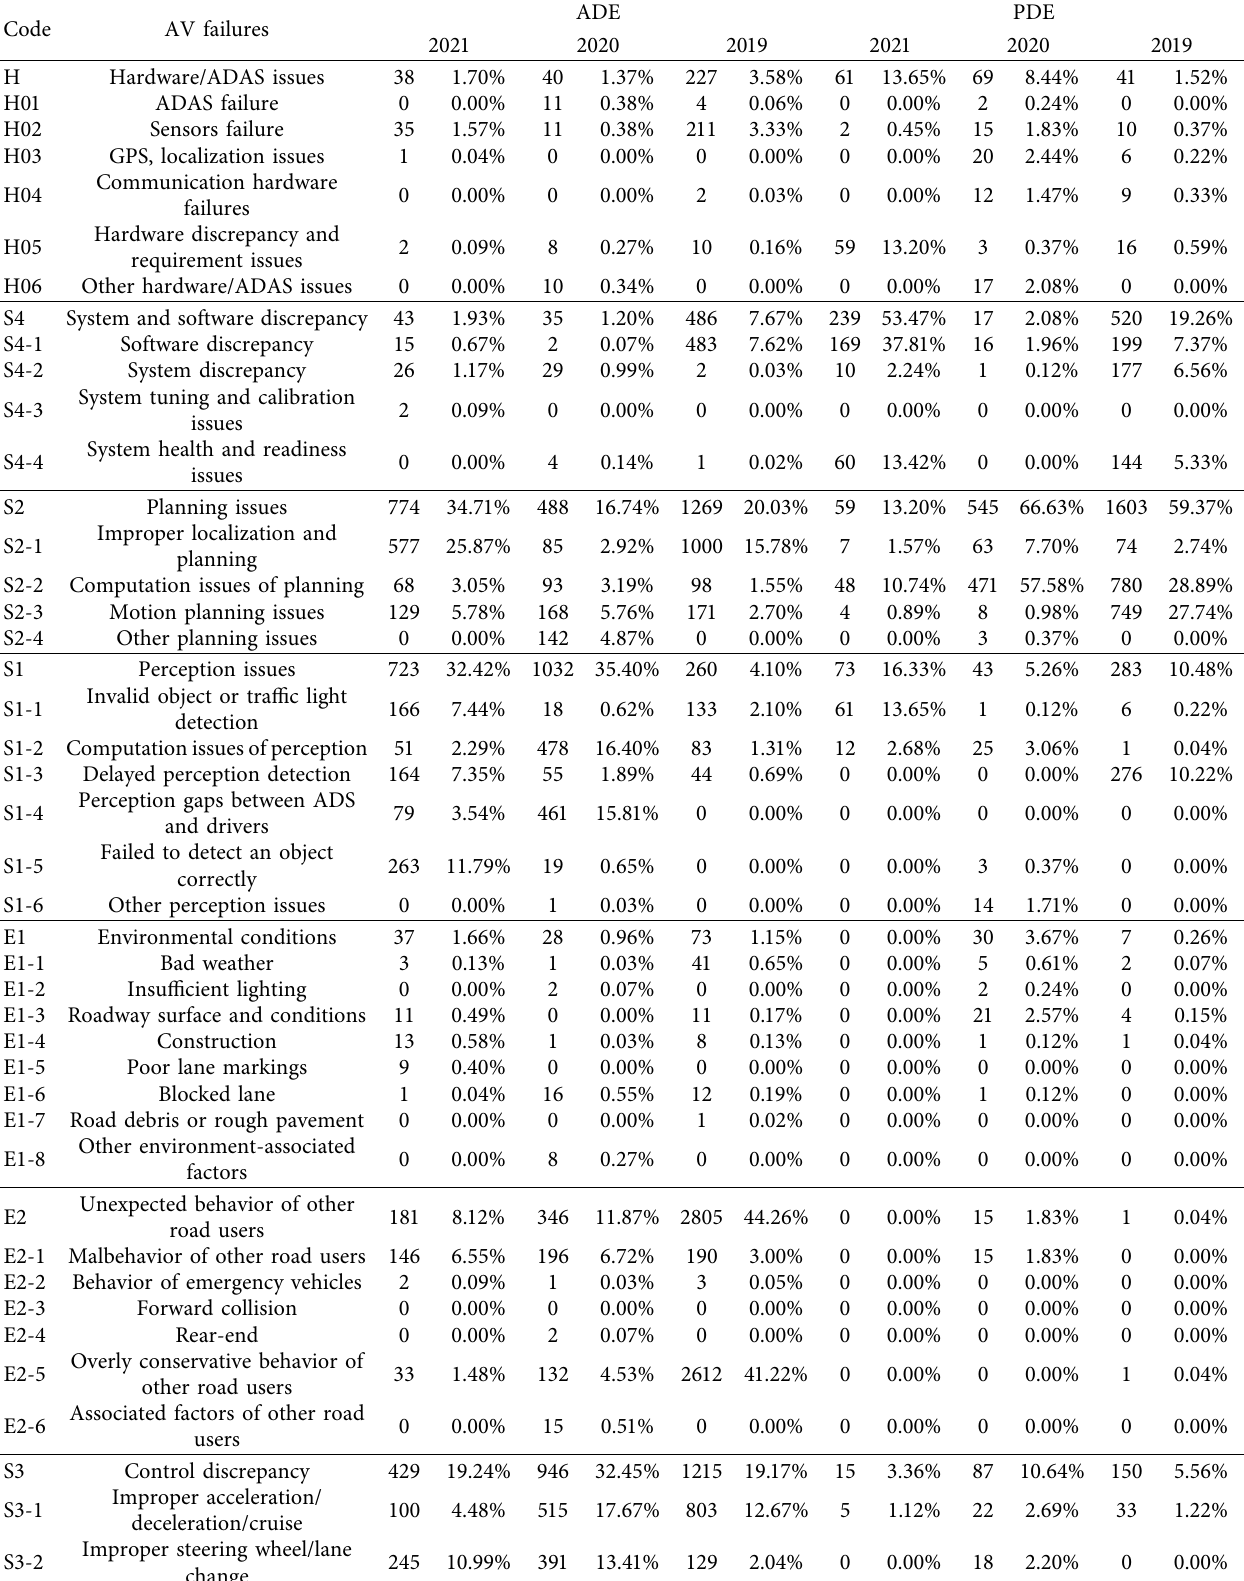
Table 4: Potential risk assessment results through 2019–2021 DMV AVT disengagement reports (grouped by accident